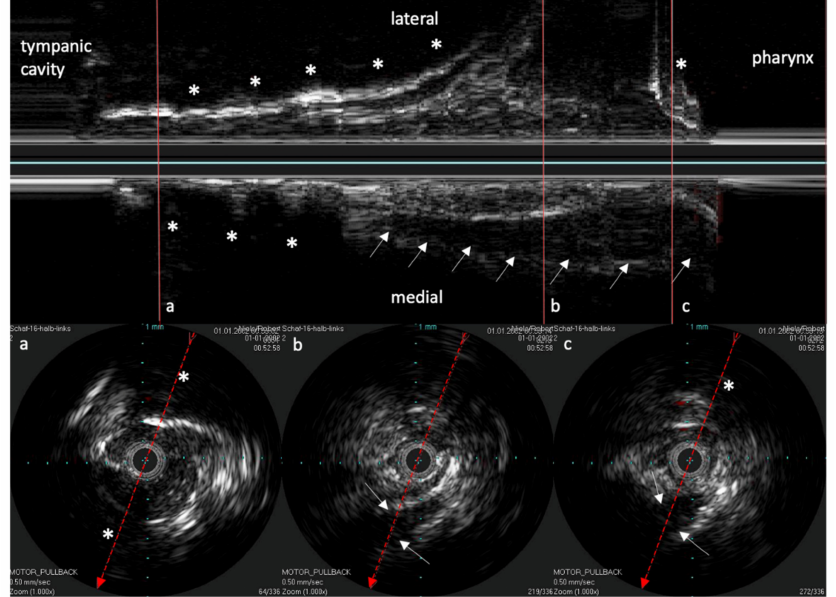
Figure 4. Longitudinal image of the ET with the corresponding cross sections. ( a ) near the ET isthmus. ( b ) in the middle section of the ET. ( c ) near the pharyngeal ostium. Bone is marked with *. The bony structures represent consistent topographic landmarks. The cartilage of the ET shows low echogenicity (white arrows). Note that the dashed red line in the cross-sectional image represents the axis of the longitudinal image. The tip of the arrow points toward the lower part of the longitudinal image.